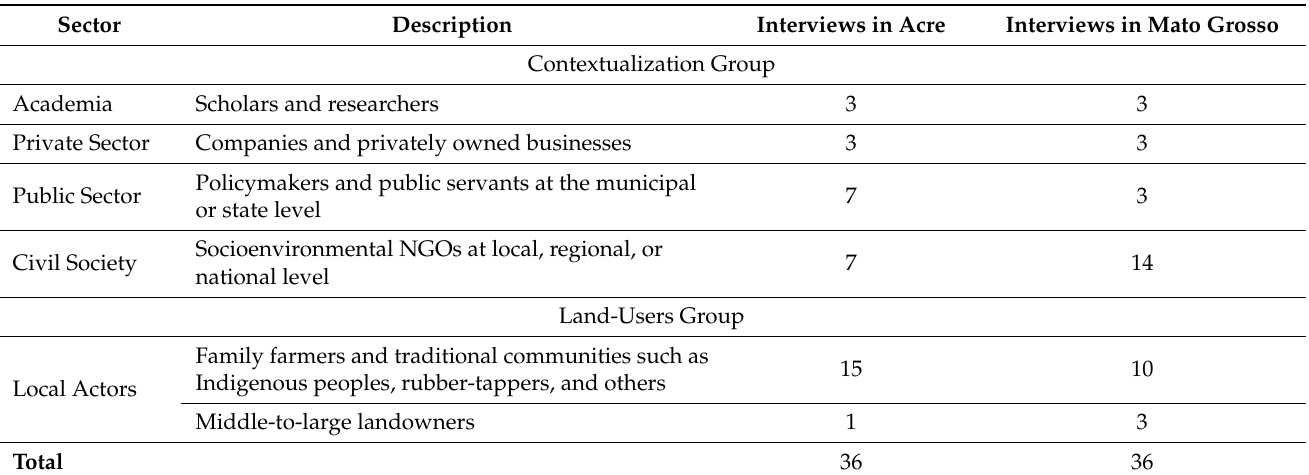
Table 1. Stakeholders interviewed during